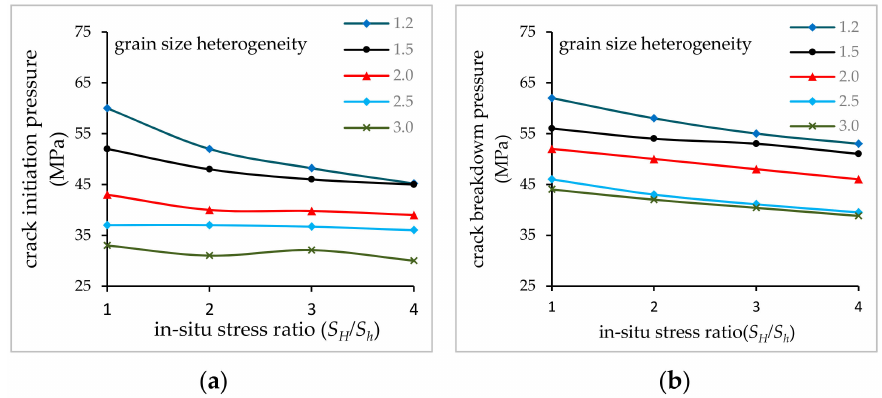
Figure 12. Effect of in-situ stress ratio on ( a ) initiation and ( b ) breakdown pressure under different grain size